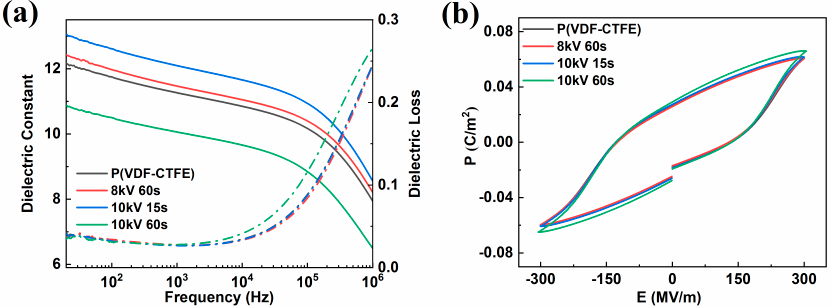
Figure 4. Characterization of the low ‐ field and high ‐ field dielectric properties of films. ( a ) The dielectric constant (solid lines) and loss (dotted lines) at different frequencies. ( b ) The polarization ‐ electric field (P ‐ E) loop at 300 MV/m.